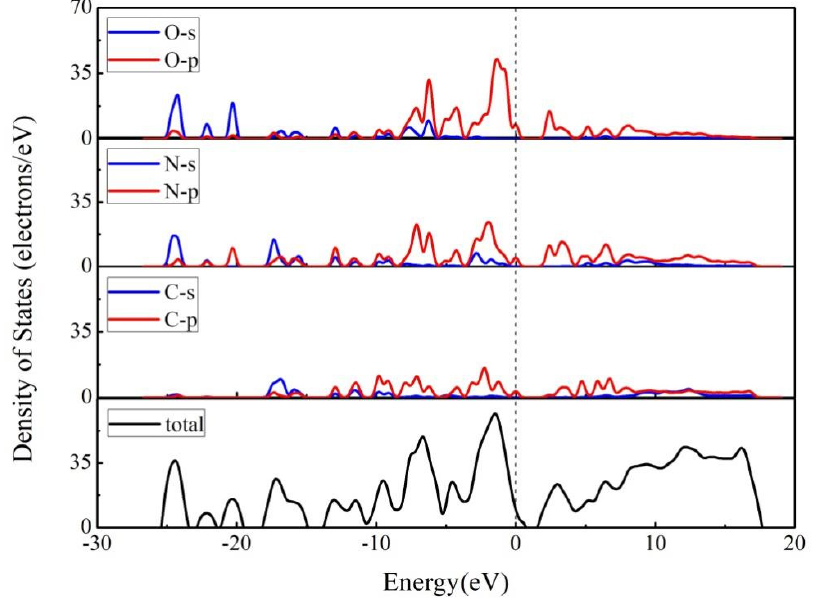
Figure 5. The density of states of DNTF at 0 GPa.